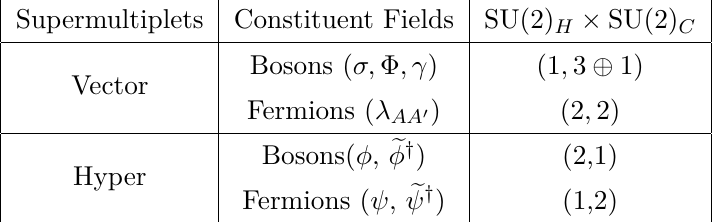
Table 3 . The field content of three dimensional N = 4 vector multiplet and hypermultiplet, along with the representations of R-symmetry in which they transform. Note that for the vector multiplet bosons, σ is a real non-compact scalar, Φ is a complex scalar, and γ is a real compact scalar dual to the 3d gauge field. For the hypermultiplet bosons, φ and e φ are both complex scalars.